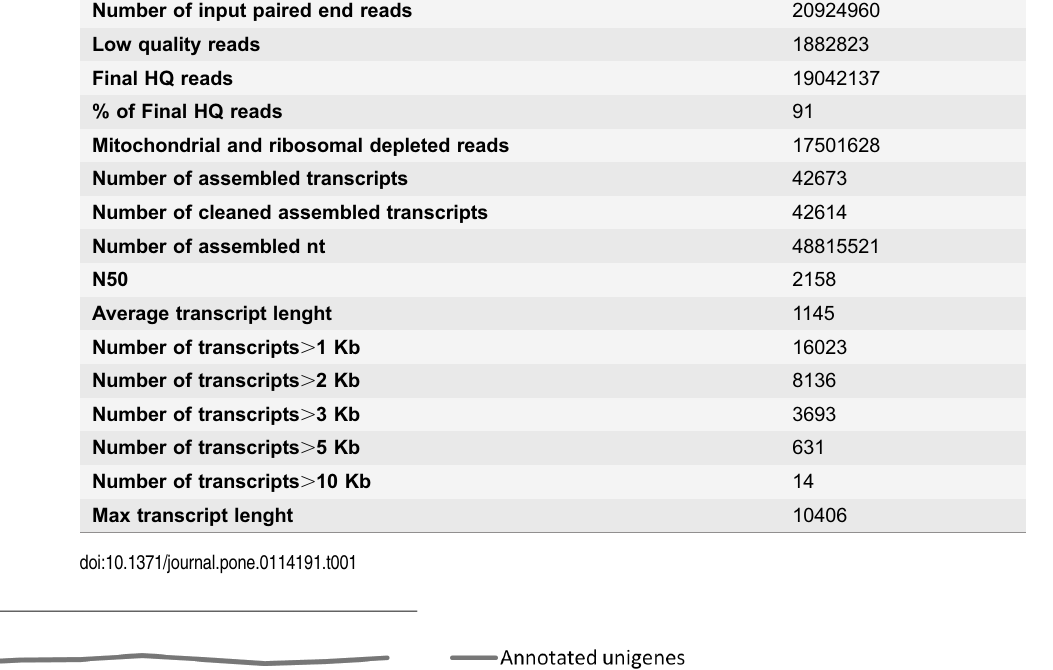
Table 1. Sequencing and assembly statistics.